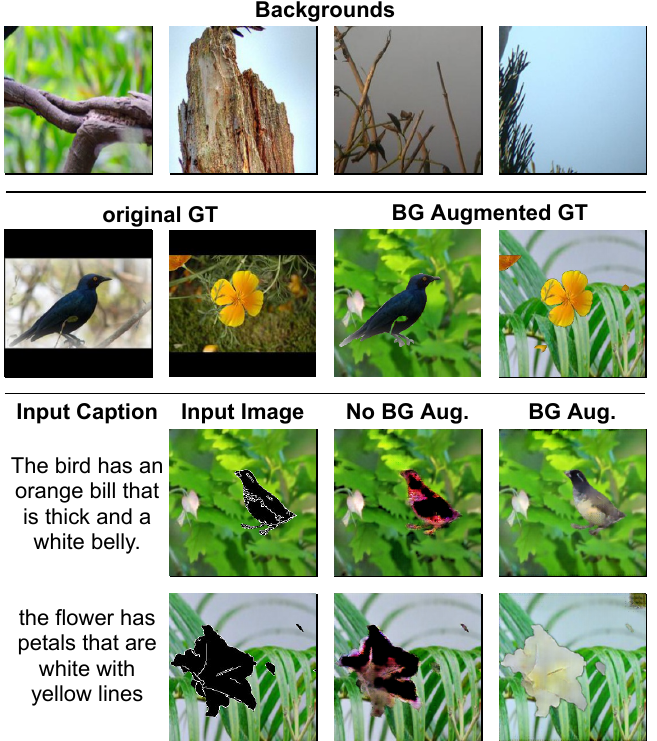
Figure 9. Backgrounds, GT augmentations and examples of generation failures and successes are reported here, showing the importance of the generalization